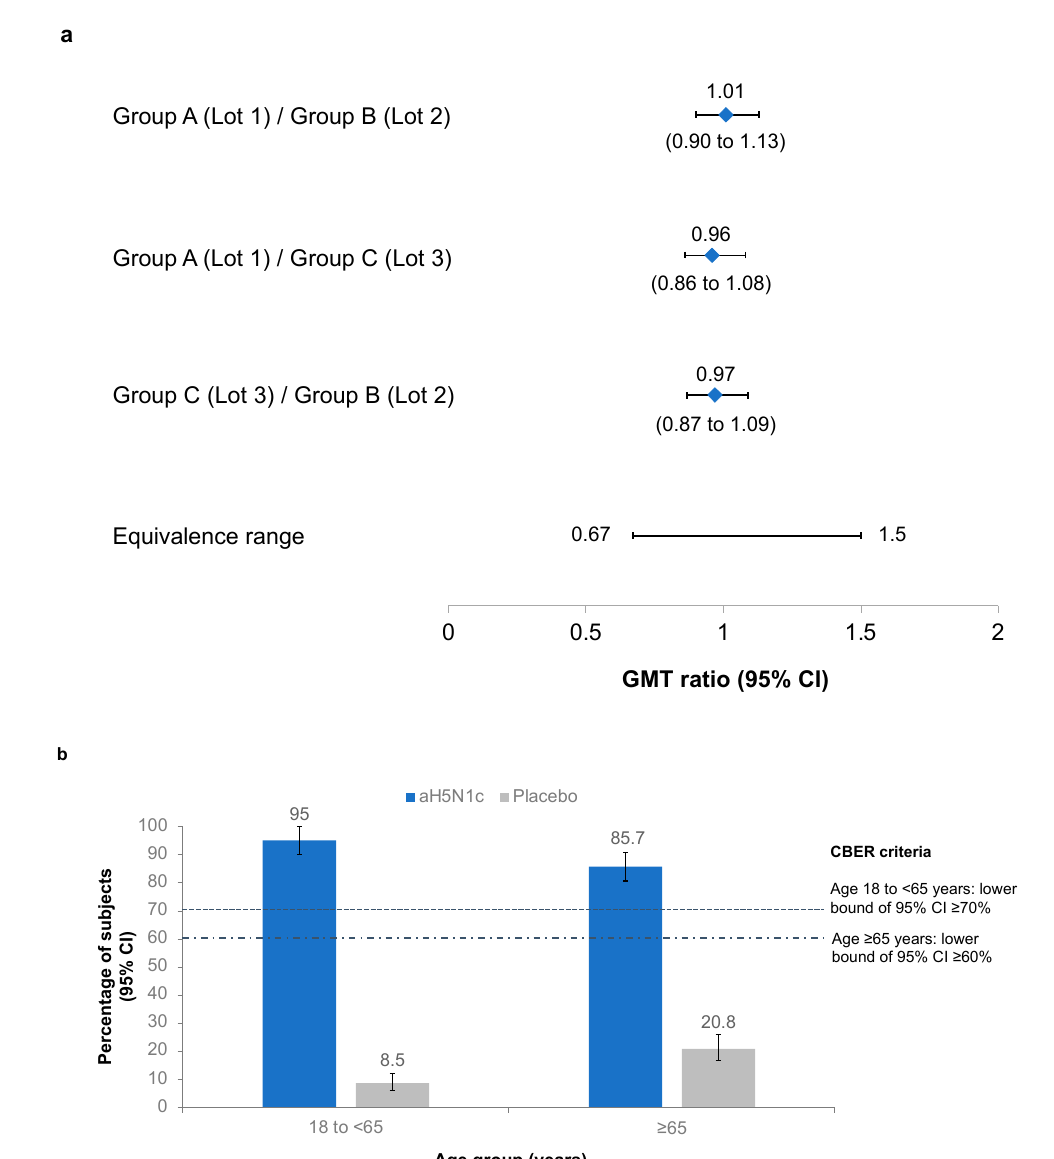
Figure 2. ( a ) Pairwise comparisons of the geometric mean titer (GMT) ratios of hemagglutination inhibition (HI) titers from Groups A (Lot 1, No.181053), B (Lot 2, No.181054), and C (Lot 3, No.181675). Protocol-defined equivalence range of the 95% confidence intervals (CI) was 0.667 to 1.5. ( b ) Pro- portion of subjects with HI ≥ 1:40 on Day 43 in the pooled aH5N1c and placebo groups. Center for Biologics Evaluation Research (CBER) criteria were met if the lower bound of the 95% CI was ≥ 70% in subjects aged 18 to <65 years and ≥ 60% in subjects aged ≥ 65 years.